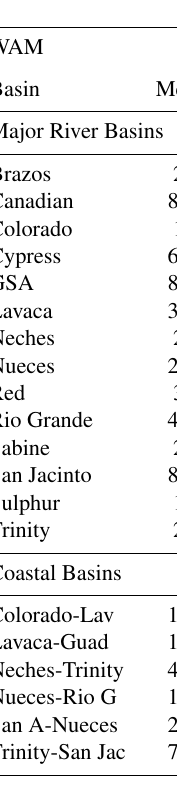
Table 4. Frequency metrics for naturalized flows at basin outlets in m 3 s − 1